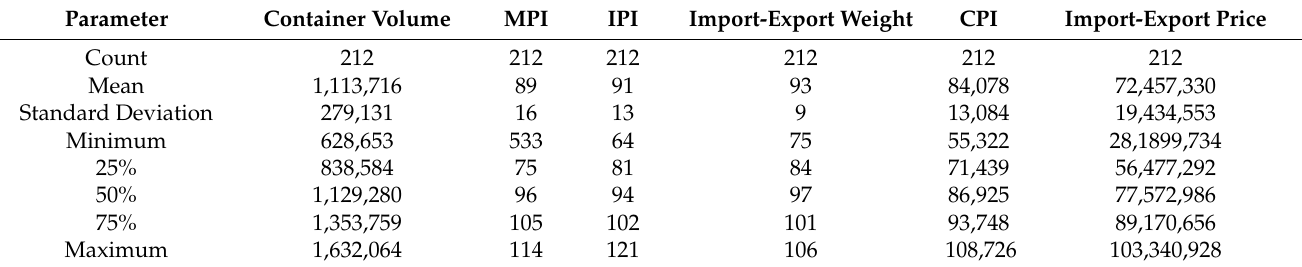
Table 3. Summary statistics of the